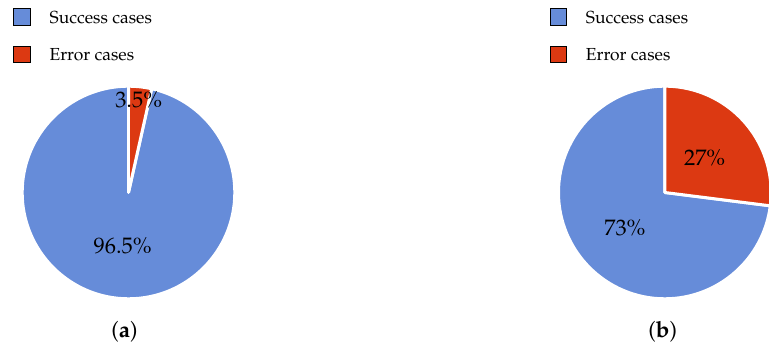
Figure 4. Error rate using non-glossy surface paper. ( a ) With thick wheel model; ( b ) With Bookreader 2 model.